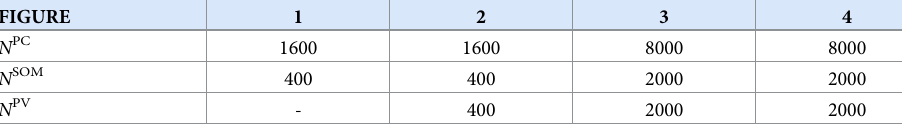
Table 3. Number of neurons in each populations for the different figures. FIGURE 1